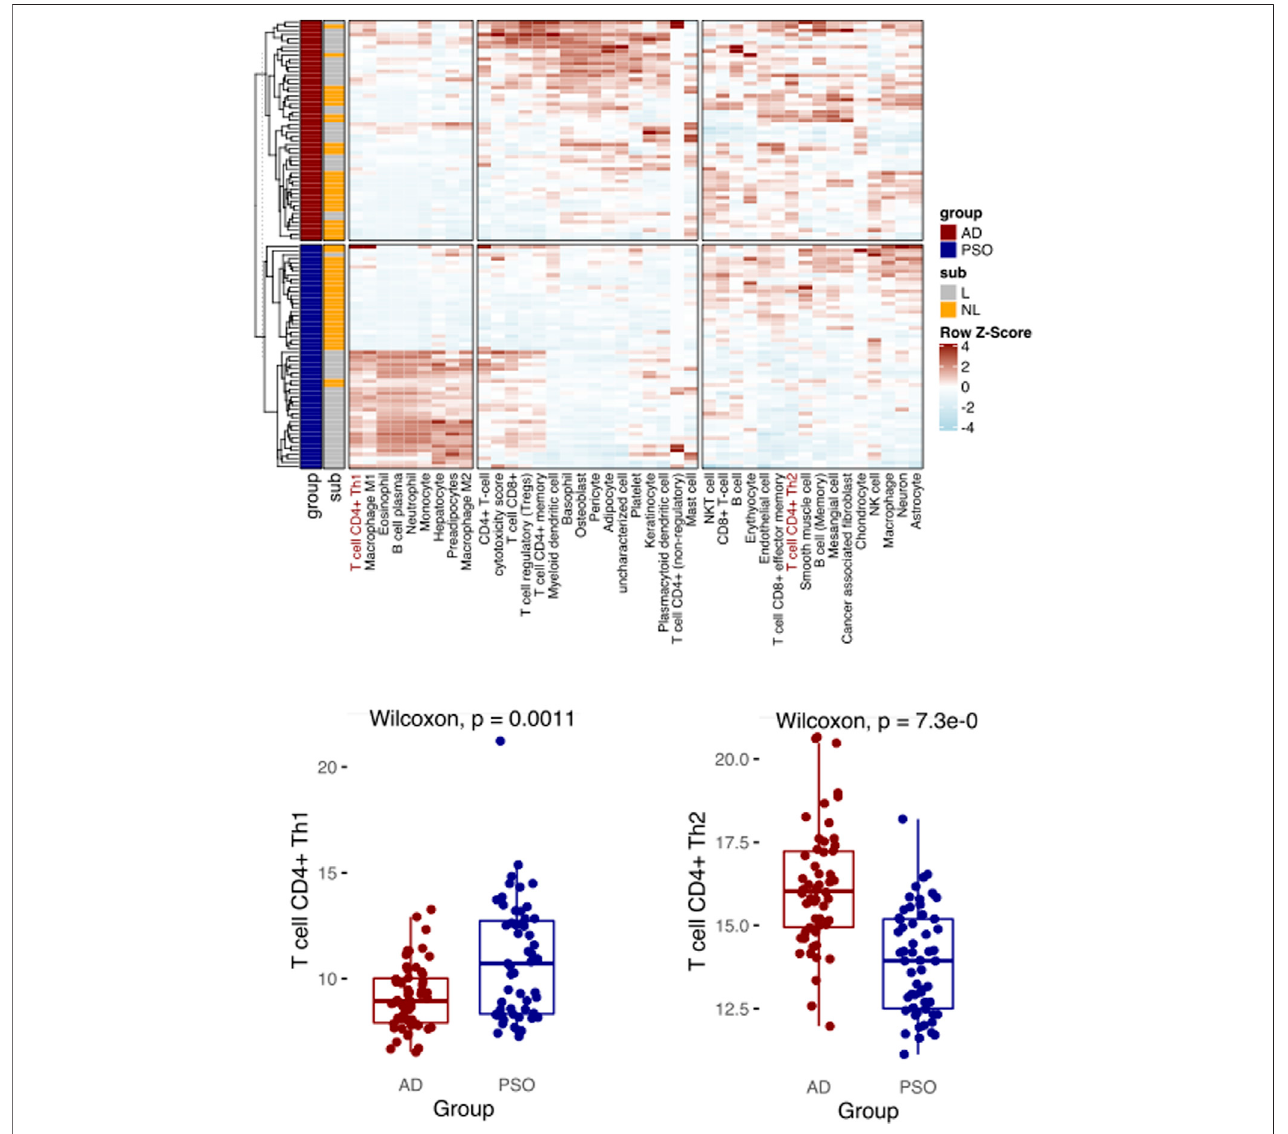
FIGURE 3 | Decosus identi fi es the Th1 and Th2 differences between atopic dermatitis and psoriasis. (Top) Heatmap of Decosus estimated cell fractions across atopicdermatitis(AD, n =54)andpsoriasis(PSO, n =55)samplesfromGSE121212.Withintheplot,Th1andTh2cellsareindicatedinred,whileothercellsofinterestare highlightedwithblue.(Bottom)BoxplotsoftheDecosusestimatesofTh1cells(left)andTh2(right)fractionsacrossskinsamplesofADandPSO.MultipletestadjustedT. test p values are indicated. Within the heatmap, NL = non-lesional and L = lesional.